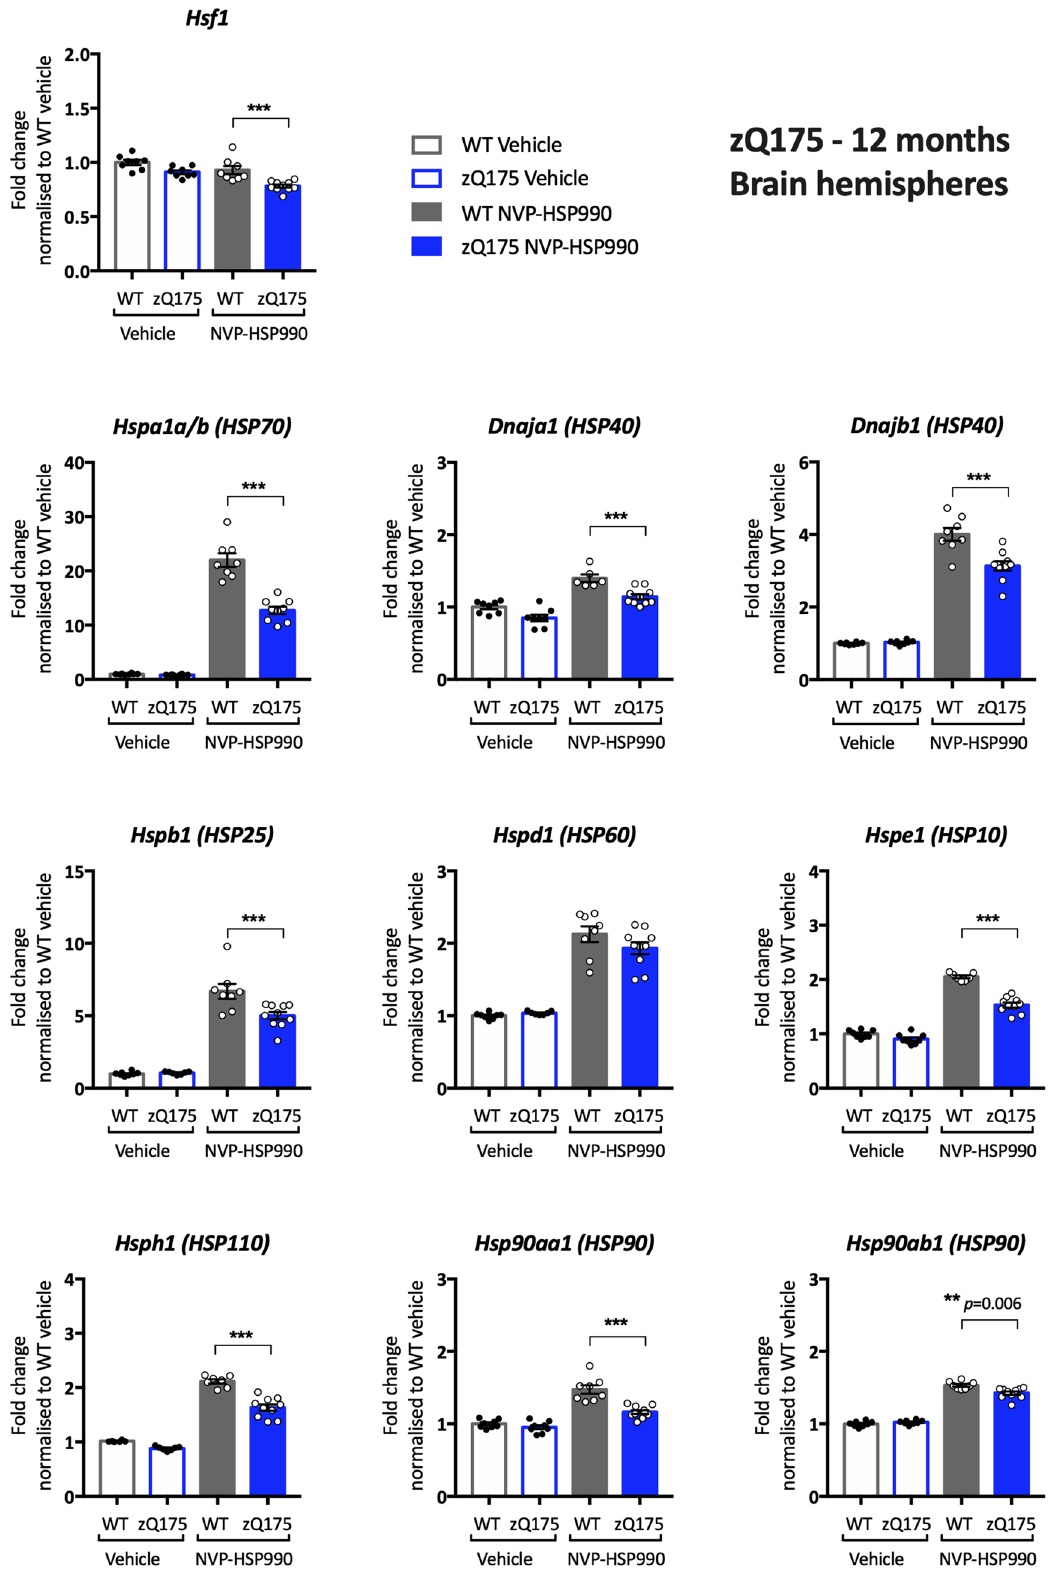
Figure 5. Analysis of the heat shock response in the brain hemispheres of zQ175 mice at 12 months of age. The expression of heat shock genes was measured using the QuantiGene 16-plex assay in the brain hemispheres of wild- type and zQ175 mice at 12 months of age that had been treated with vehicle or NVP-HSP990. The NVP-HSP990 treated samples were normalised to the corresponding wild-type vehicle treated samples. N = 6–10/genotype/treatment. Statistical analysis was by two-way ANOVA with Bonferroni correction for multiple comparisons. Mean ± SEM. *** p ≤ 0.001. Test statistical values can be found in Supplementary Table S12 online. WT